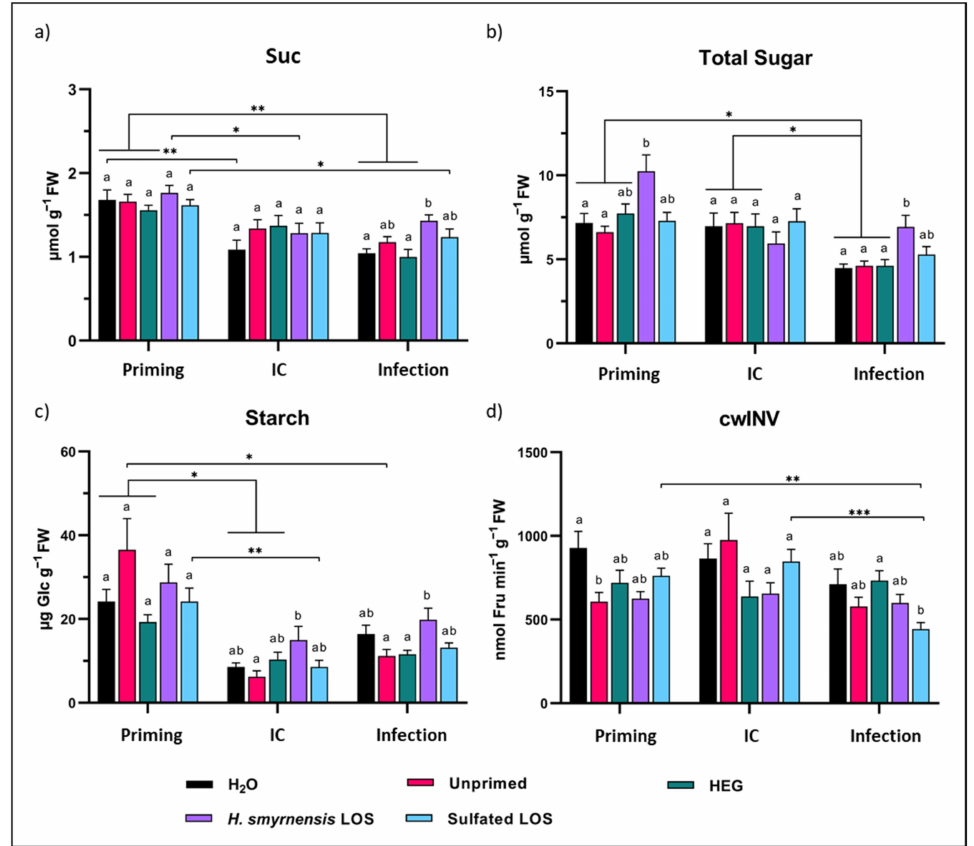
Figure 6. Effect of fructan priming on small soluble sugars, starch and cell-wall invertase (cwINV) in the rocket- Botrytis cinerea pathosystem. Glucose, fructose and ( a ) sucrose (Suc) levels were measured on HPAEC-IPAD. ( b ) Total sugar was calculated based on these results. ( c ) Starch content was measured by following Glc production due to starch degradation. ( d ) cwINV activity was assayed as the increase in Fru from Suc hydrolysis. Samples were taken after priming or after inoculation with infection buffer (infection control, IC) or infection buffer with fungal spores. Bars represent the mean ± SEM. A total of 6 biological replicates were used per treatment and the experiment was repeated three times with consistent results. Letters indicate significant differences between treatments within the same time point ( p < 0.05). Asterisks indicate significant differences of the same treatment between time points (* p < 0.05; ** p < 0.01; *** p <